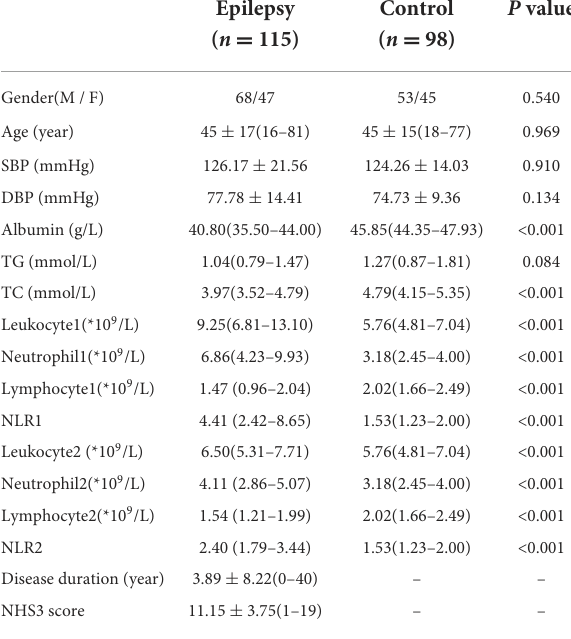
TABLE 2 Demographic and laboratory characteristics of patients with epilepsy and